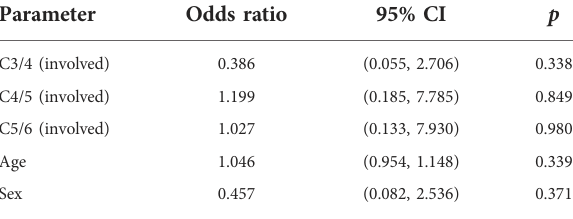
TABLE 6 Odds ratio, 95% CI and P value association using multiple factors logistic regression models for vertigo meeting the MCID including cervical levels.